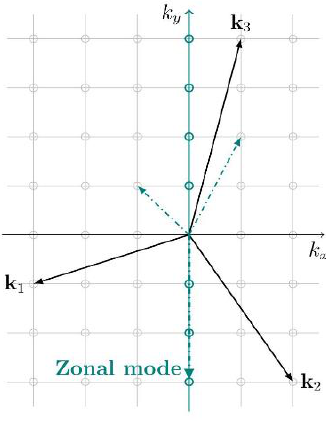
Figure 5. Color online. Triads on an integer lattice 2. Here, each lattice point represents a particular mode (𝑘 𝑥 , 𝑘 𝑦 ) = (𝑚, 𝑛) . The resonant triad (black, solid) and the zonal triad (teal, dot-dashed) from Figure 1 are shown. The zonal mode has 𝑘 𝑥 = 𝑚 = 0 and therefore lies on the 𝑘 𝑦 axis. In the next section, we illustrate the dynamics of a detuned resonance, both in isola- tion and when coupled to another (exact) resonance (Figure 6). A particular case of the